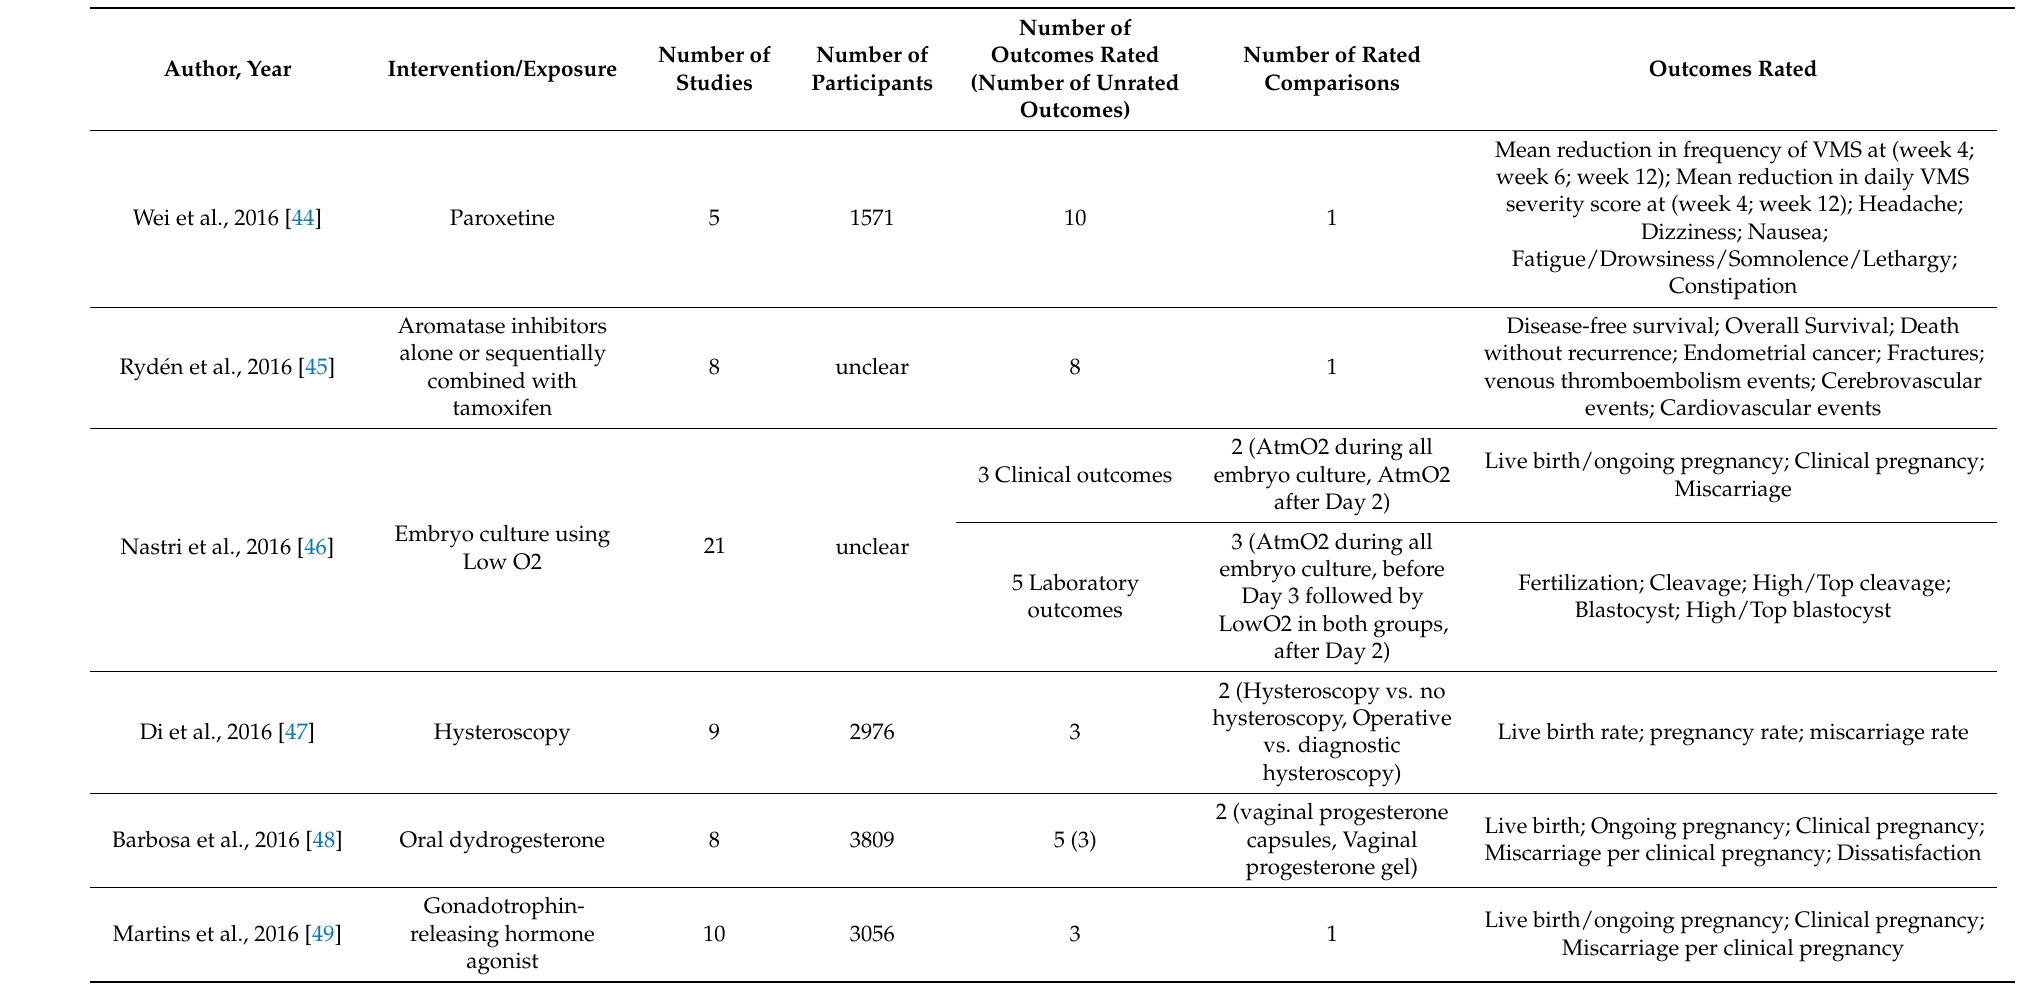
Table 2. Summary of the study characteristics and the number and type of (un)rated outcomes of systematic reviews of randomized controlled trials ( n = 41) that rated the outcome-specific certainty of evidence with